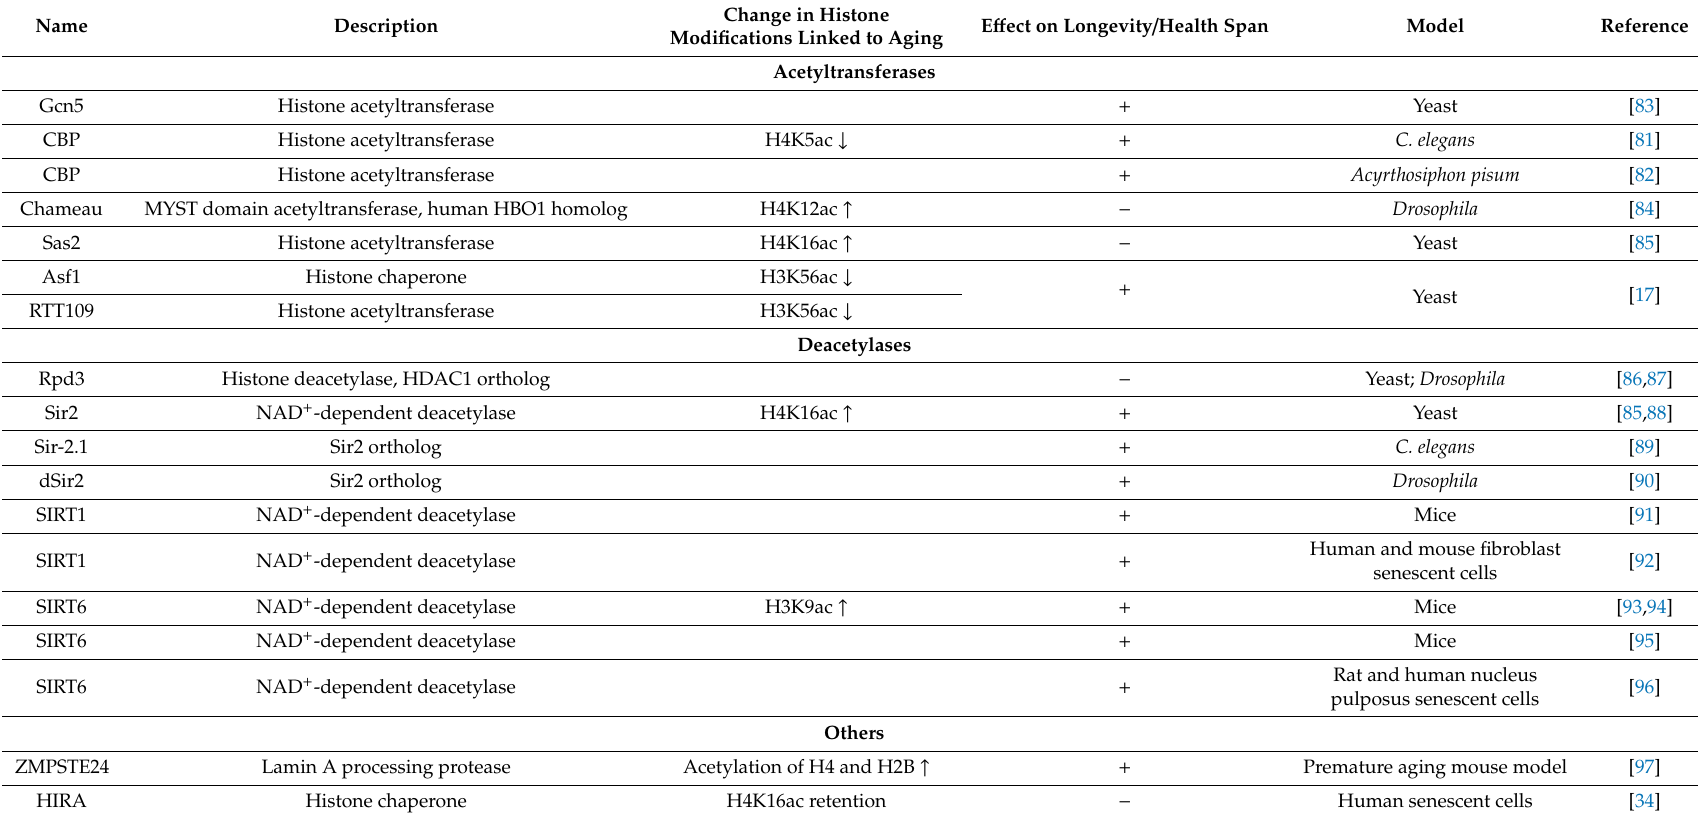
Table 3. Histone acetylation-modulating proteins and